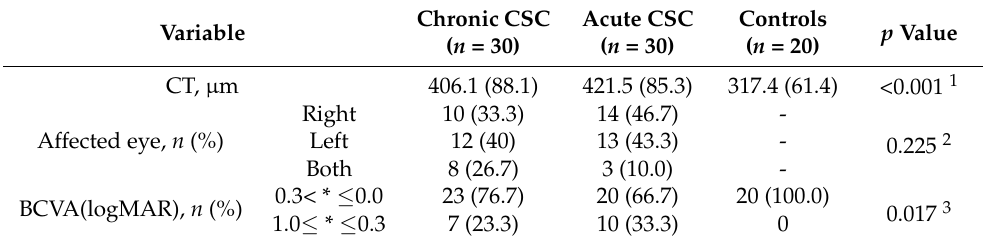
Table 2. Ophthalmological characteristics of patients with acute and chronic central serous chori- oretinopathy as well as controls.